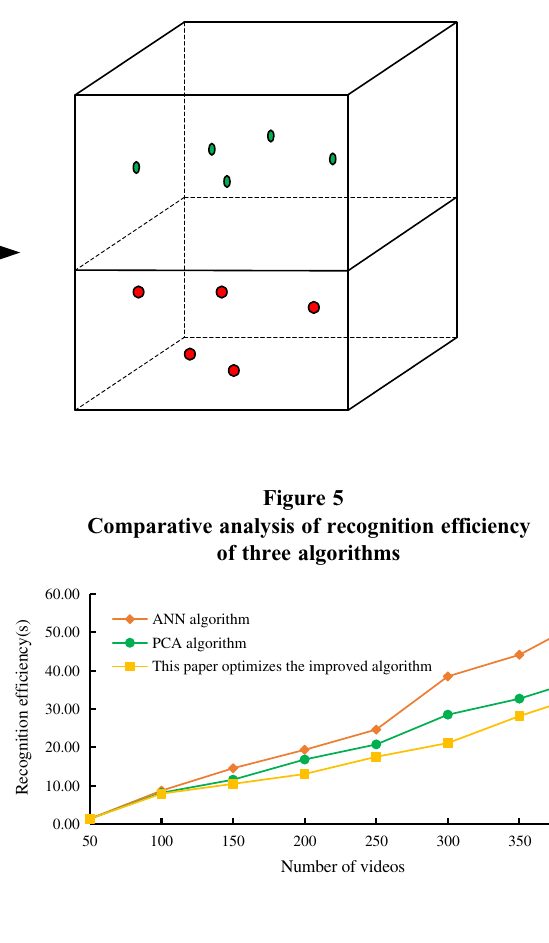
Schematic diagram of transforming nonlinear problems into linear problems in high-dimensional space